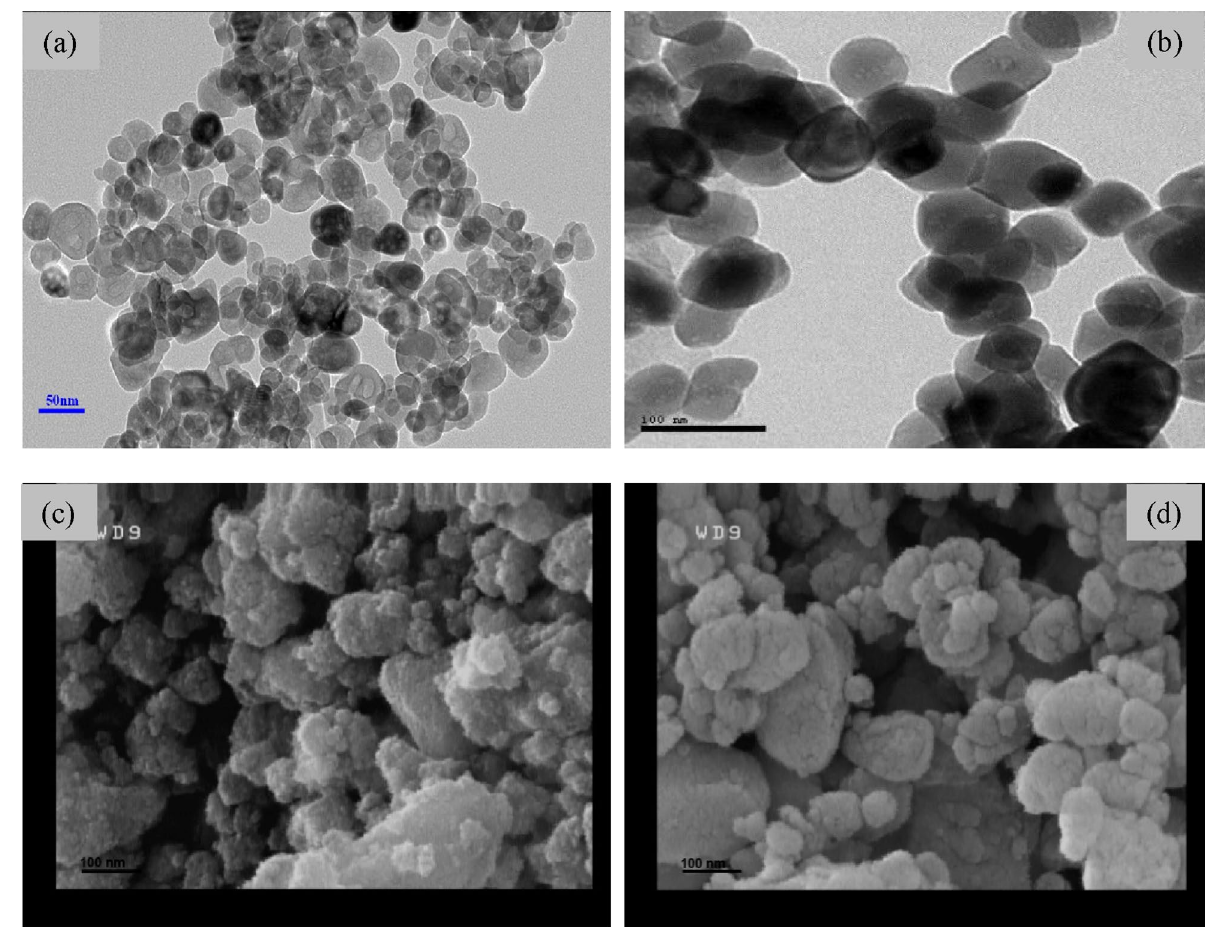
Figure 2. FESEM analysis of ( a ) hematite 38 , ( b ) calcite 39 , ( c ) dolomite, and ( d ) magnetite NPs.